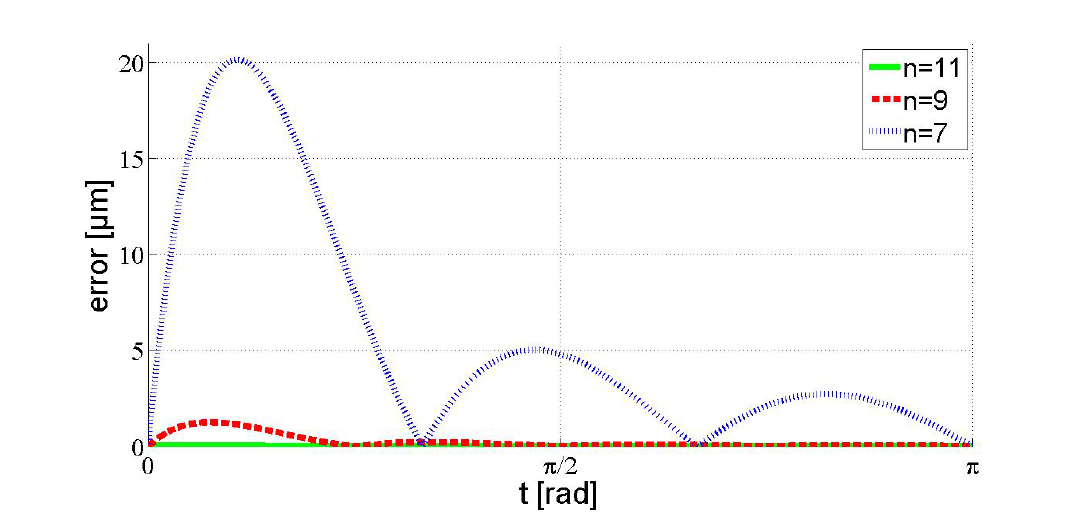
Figure 7. Interpolation errors obtained by the high relative accuracy (HRA) method IB1.